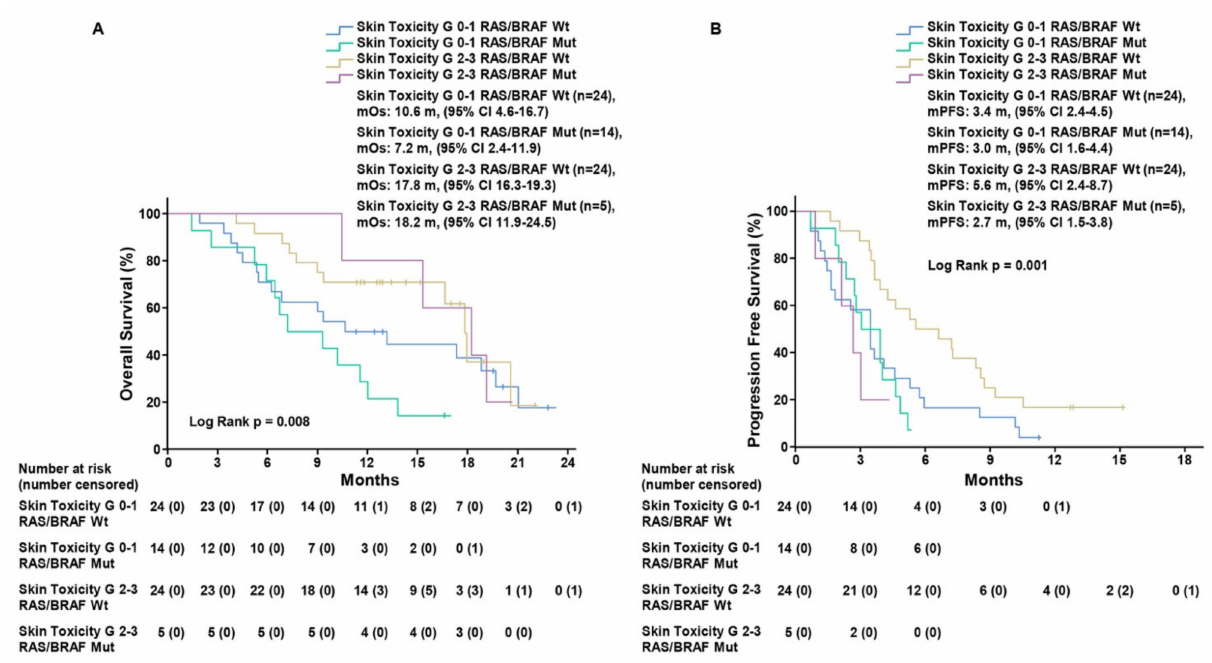
Figure 2. Kaplan–Meier estimates of overall survival ( A ) and progression-free survival ( B ) in patients with RAS/BRAF/EGFR wild-type and mutant circulating DNA according to skin toxicity grade 0–1 and grade 2–3. Grade, G; median overall survival, mOS; median progression-free survival, mPFS; months,